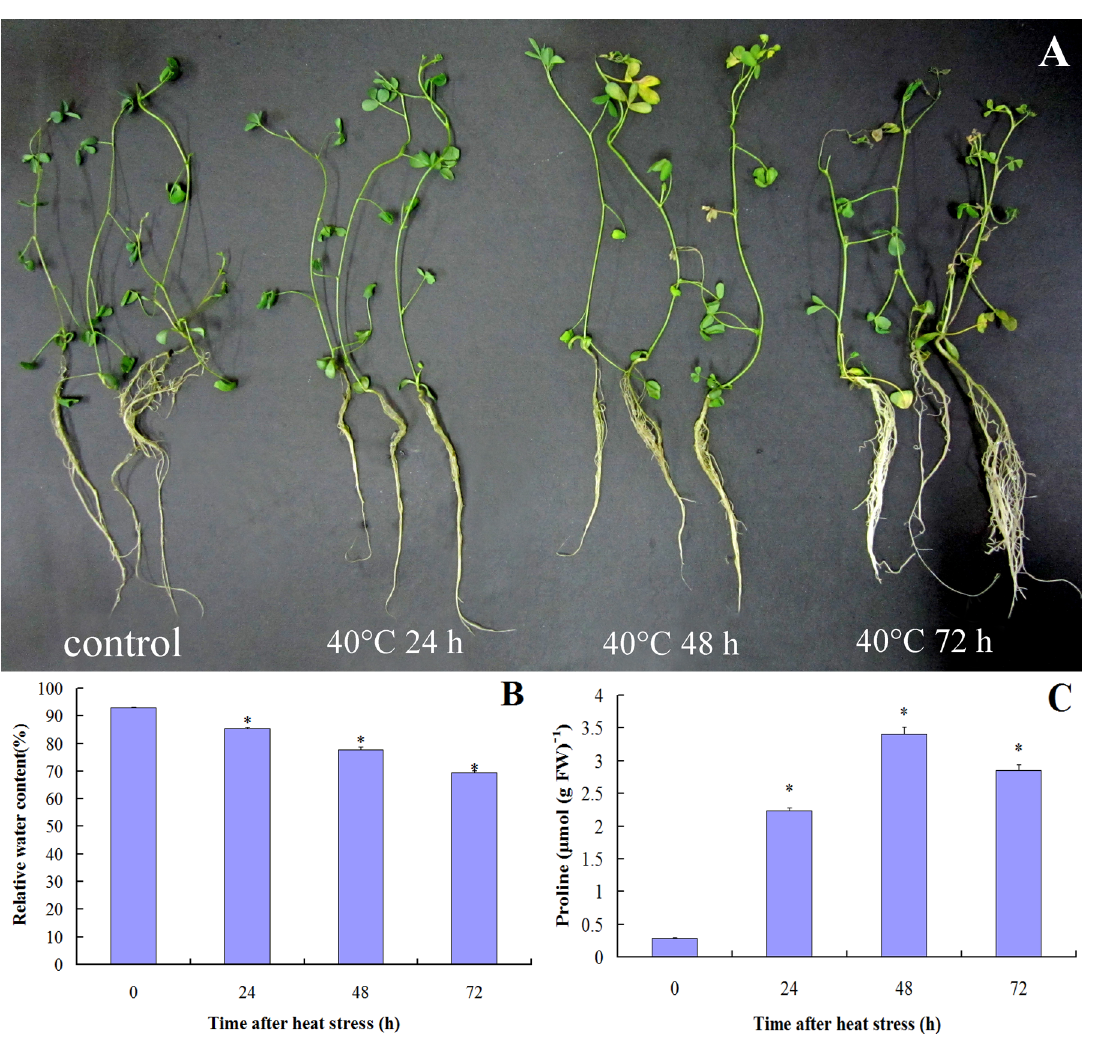
Figure 1. Phenotypic and physiological changes in alfalfa seedlings under control and heat stress (40 u C for 24, 48 and 72 h). (A). Phenotypic changes (B). RWC (C). Proline content. Three independent biological replicates were used in each treatment. Asterisks indicate statistically significant differences at P , 0.05. Bars represent standard errors of triplicate experiments.